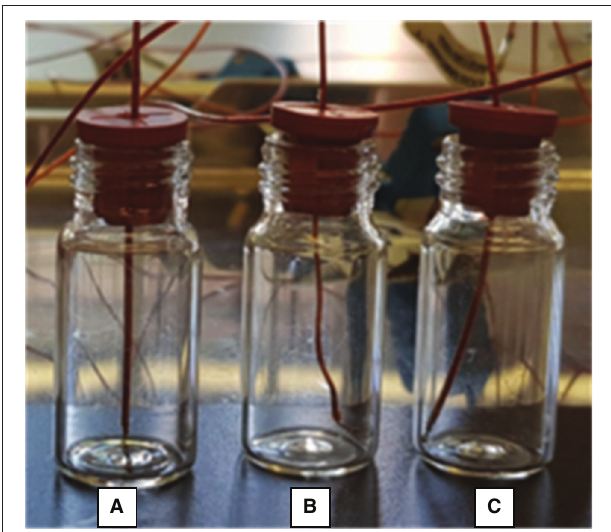
A B C FIGURE 3 | An example of the possible cases observed about thermocouple positioning: (A) correct placement, close to the bottom center; (B) lifted thermocouple with respect to vial bottom; (C) incorrect positioning, with the sensing tip in contact with the lateral wall.